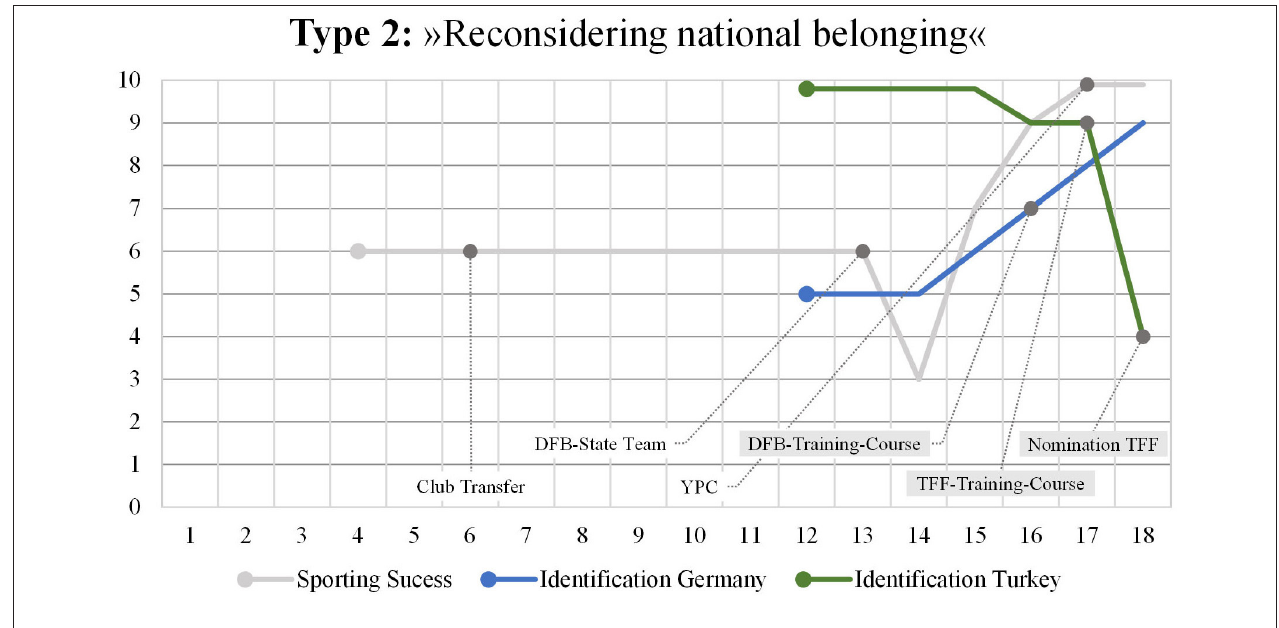
FIGURE 2 | Mapping Type